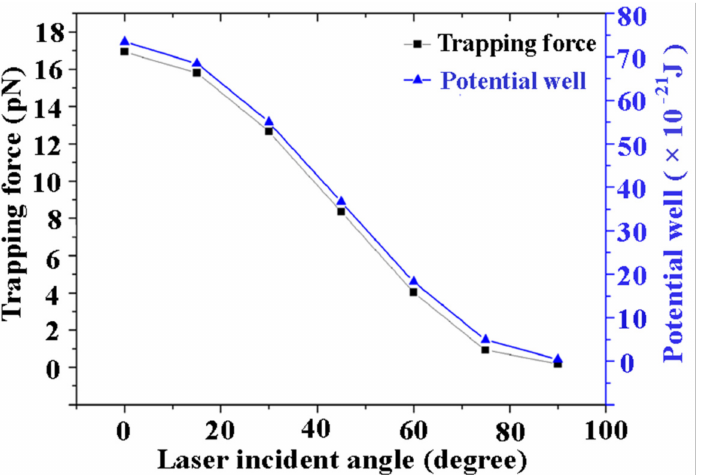
Figure 6. The trapping force exerted on Au nanospheres of a bowtie dimer and the corresponding potential well with respect to the incident angle of the laser. The Au sphere diameter is 10 nm here. The bowtie edge length is 40 nm, the bowtie gap is taken as 20 nm. The trapped 10 nm Au sphere is considered